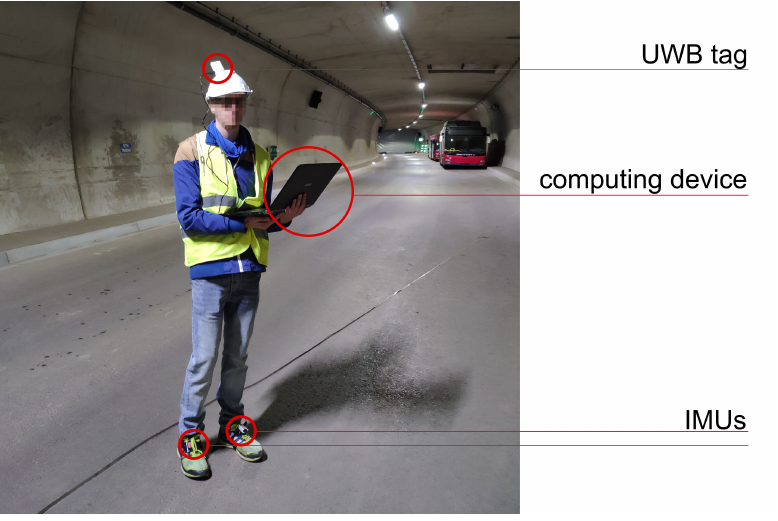
Figure 11. Test subject with sensors mounted on helmet and